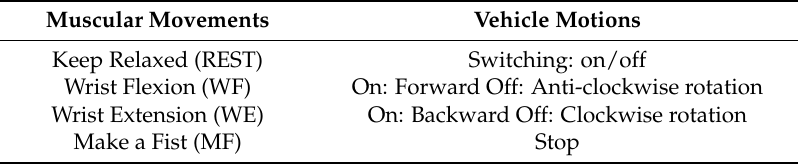
Table 4. Definition of muscular movements and control method in Paradigm 5 and